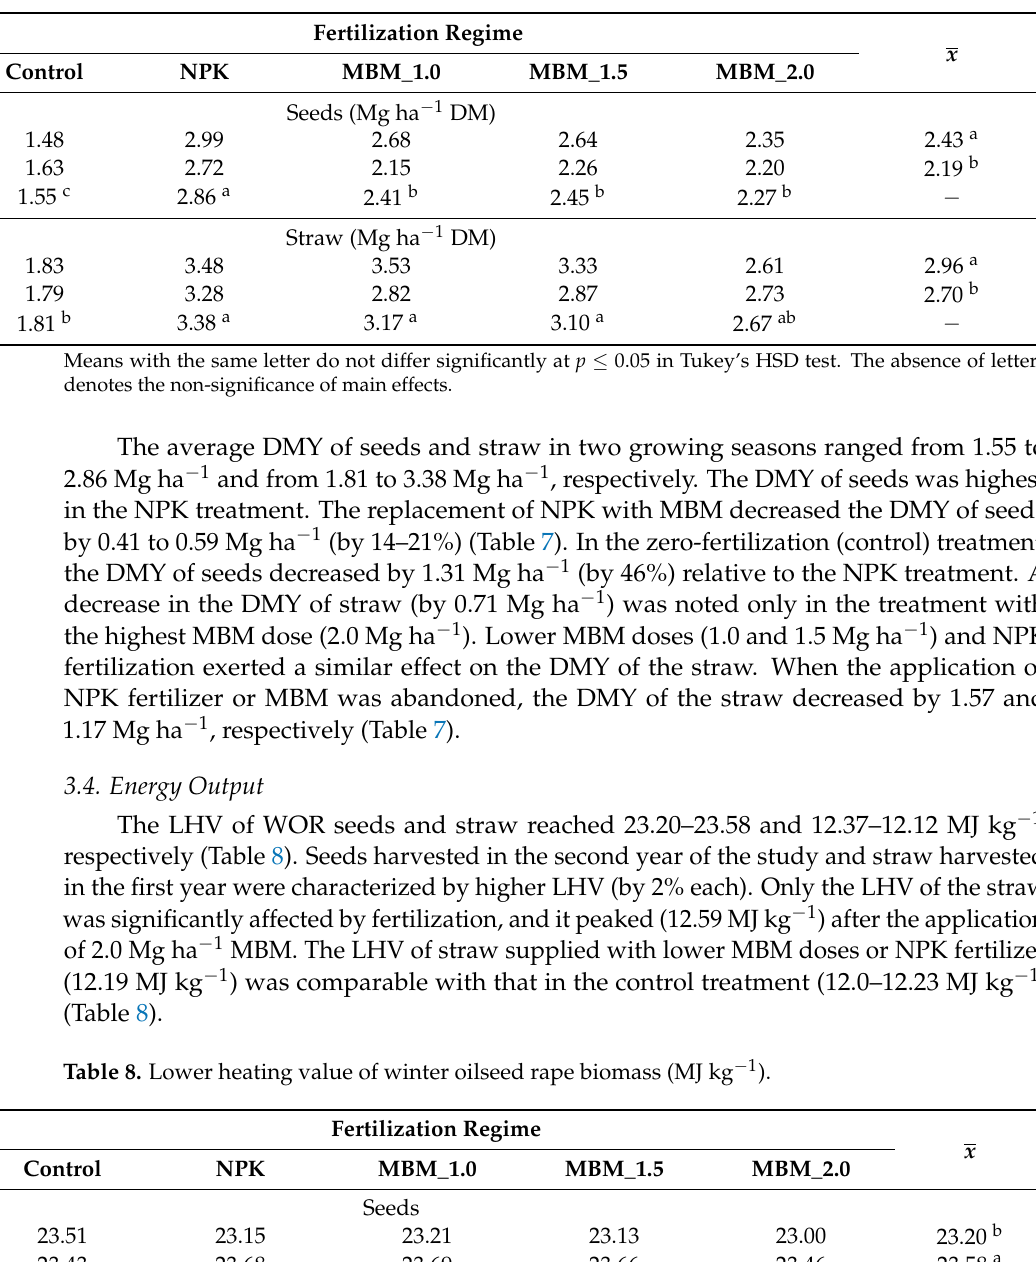
Table 7. Yield of winter oilseed rape biomass (based on Załuszniewska and Nogalska [67] and Nogalska and Załuszniewska [68]).